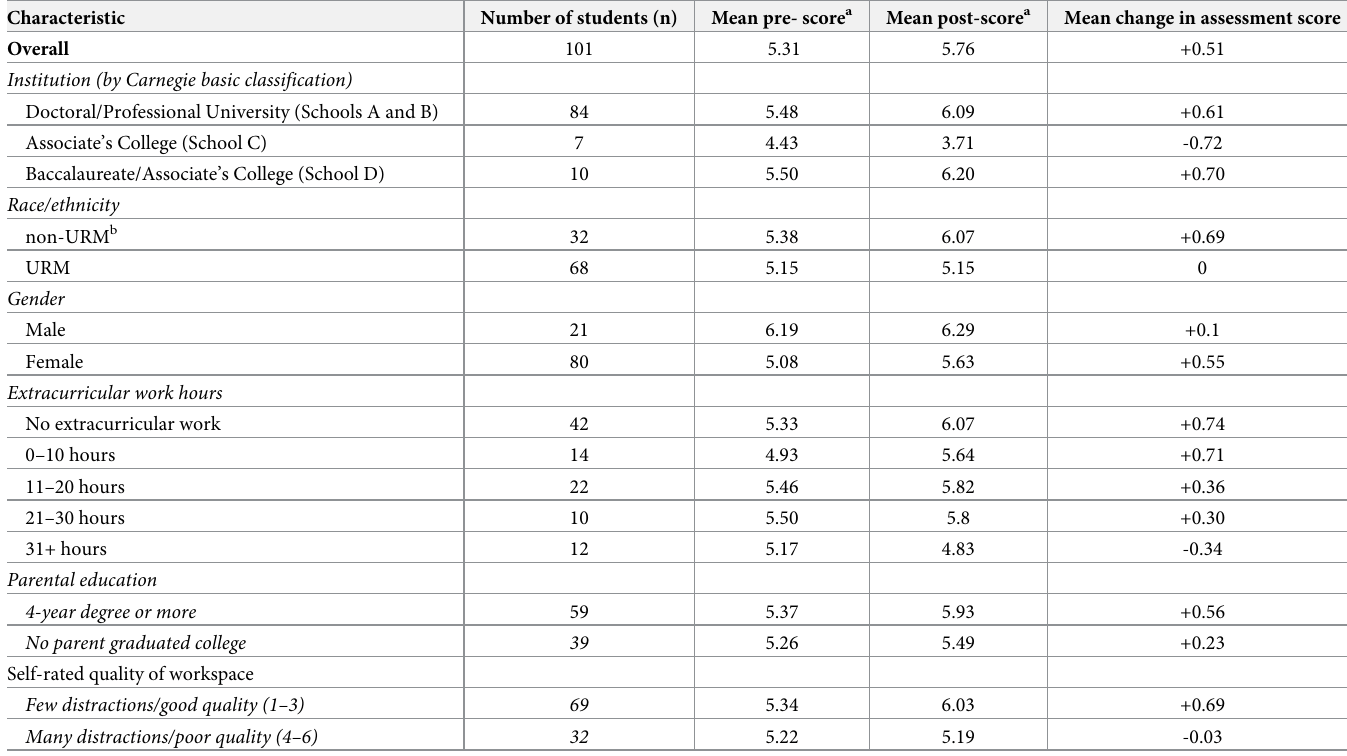
Table 5. Change in student assessment score pre- to post-module (learning gains) by student